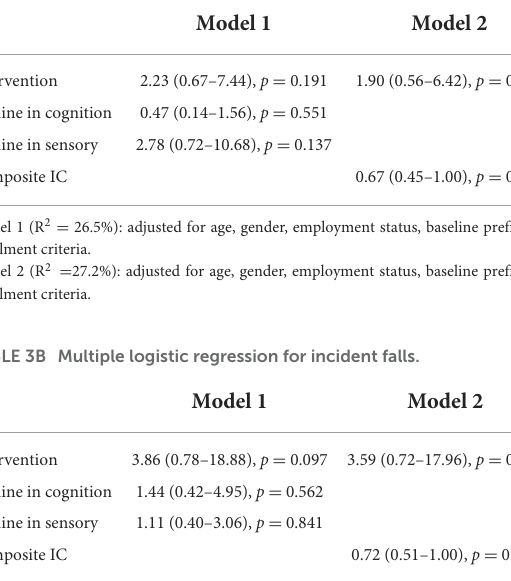
TABLE 2 Frailty and clinical outcomes at 1-year. TABLE 3A Multiple logistic regression for prefrailty at 12-month.